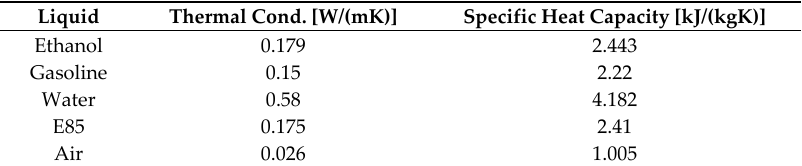
Table 1. Thermal Properties of EGW at room